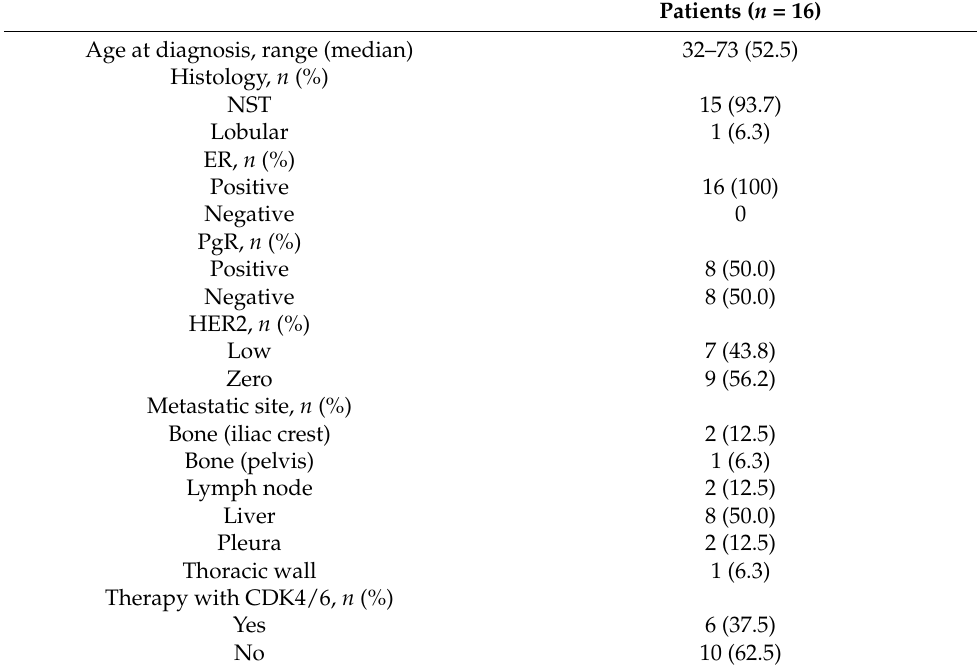
Table 1. Clinicopathological features of the patients included in this study according to the diagnosis of the primary tumor. NST, invasive carcinoma of no special type (aka ductal); ER, estrogen receptor; PgR, progesterone receptor; CDK4/6, cyclin-dependent kinase 4 and 6 inhibitors. Patients ( n = 16) Age at diagnosis, range